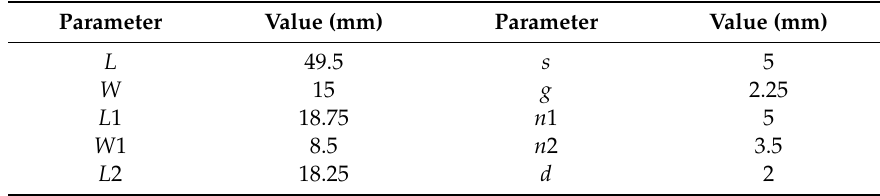
Figure 3. Simulated input impedance Za of the designed tag antenna (Figure 2b) for different gap values g . ( a ) Real part of Za ; ( b ) Imaginary part of Za . The other dimensions are defined in Table 1. Table 1. Optimized parameters of the proposed tag antenna (Figure 2b) with the NXP UCODE G2XL IC